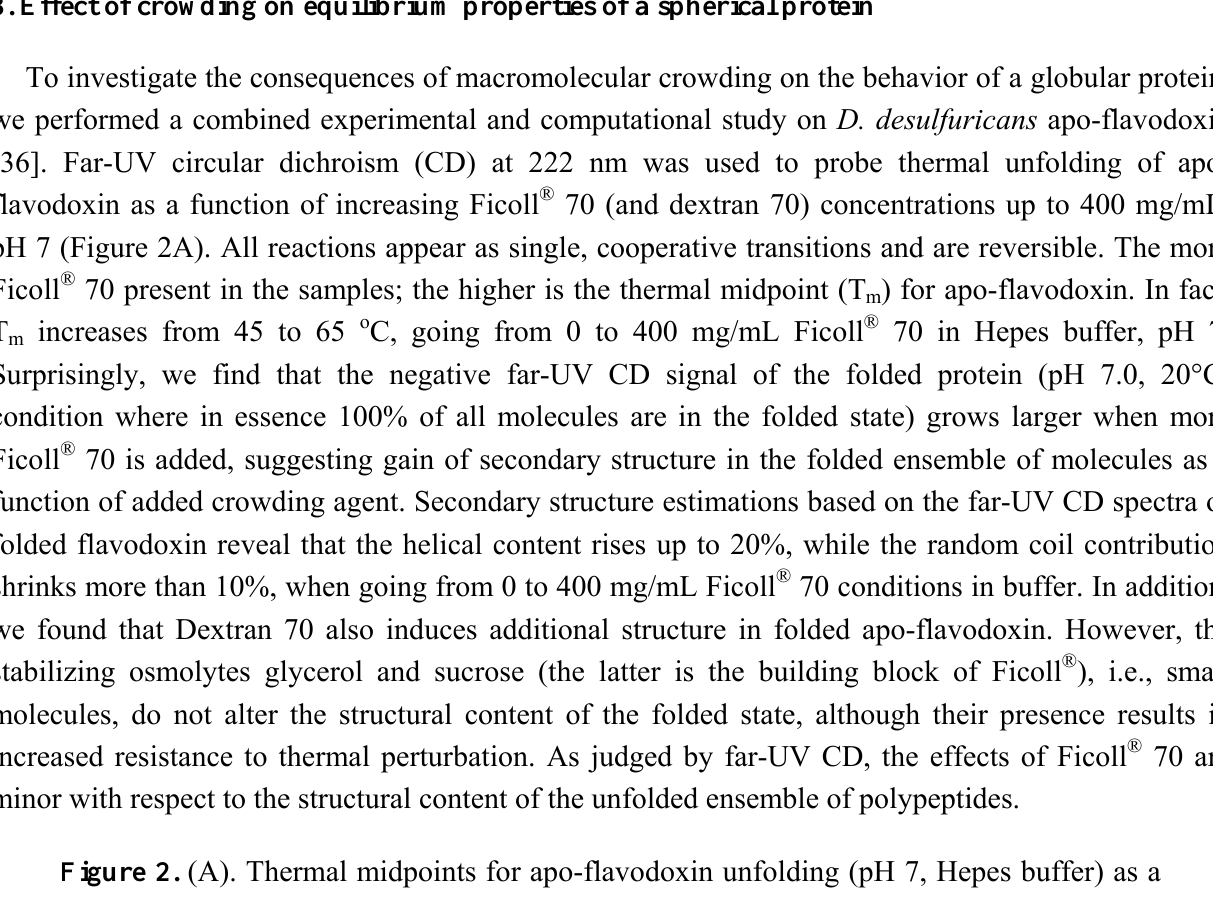
Figure 2. (A). Thermal midpoints for apo-flavodoxin unfolding (pH 7, Hepes buffer) as a function of amount of crowding agents Ficoll ® 70 (spheres) and dextran 70 (circles).